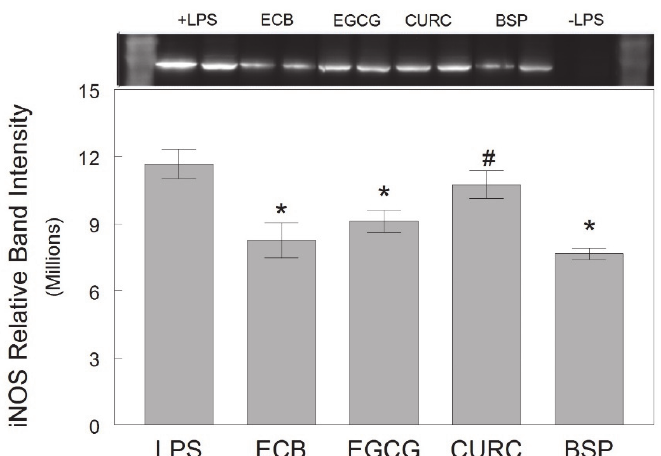
Figure 5. Expression of iNOS in HAPI rat microglial cells pre-treated with ECB or its component phytochemicals (EGCG, CURC, BSP) and stimulated 18 h overnight with LPS (100 ng/mL). Data are expressed as mean ± SEM of the immunoreactive band density per 20 µg total protein as measured by Western blot (top). Each pre-treatment was compared against LPS alone and individual components compared to ECB. Comparative post-hoc analyses were made by Fisher’s LSD post-hoc test with significance at (*) p < 0.05 versus LPS or (#) p < 0.05 versus ECB. LPS = lipopolysaccharide only; ECB = combination compound; EGCG = epigallocatechin gallate; CURC = curcumin; BSP = broccoli sprouts; − LPS = no LPS.